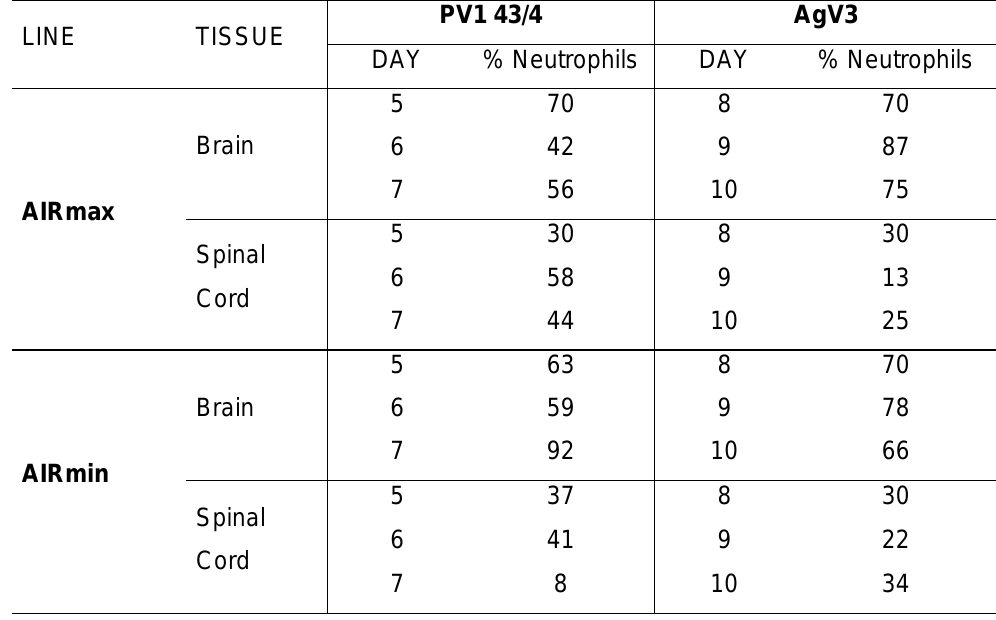
Figure 8: Histological section from the cortex of AIRmin mice. Arrows indicate an inflammation focus with lymphocytes. Table 1: Percentages of neutrophils in the brains and spinal cords of mice selected for maximal and minimal acute inflammatory reaction (AIRmax and AIRmin) infected with PV1 43/4 and AgV3 strains on different days after